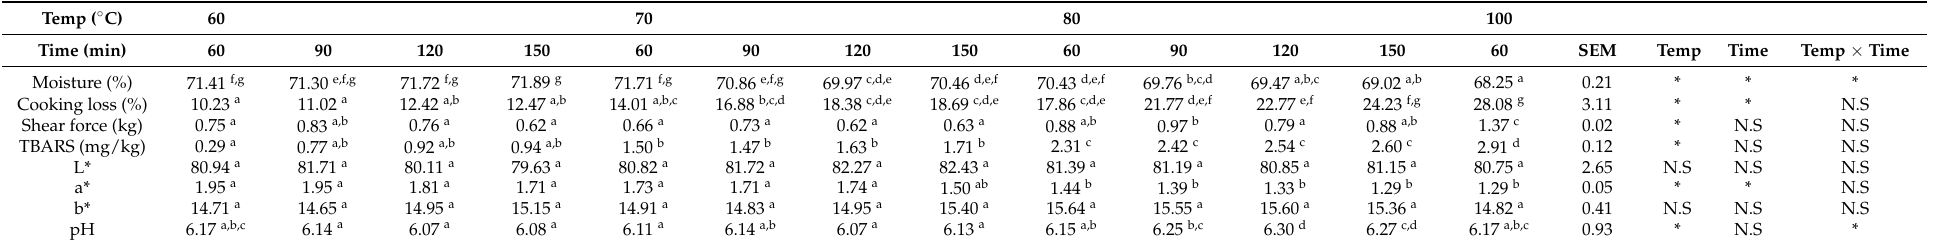
Table 3. Moisture Content, Cooking Loss, Shear Force, TBARS, Color Parameters (L*: Lightness, a*: Redness/Greenness, and b*: Yellowness/Blueness), and pH of Sous vide Chicken Breast Fillets Cooked at Different Temperature and Time